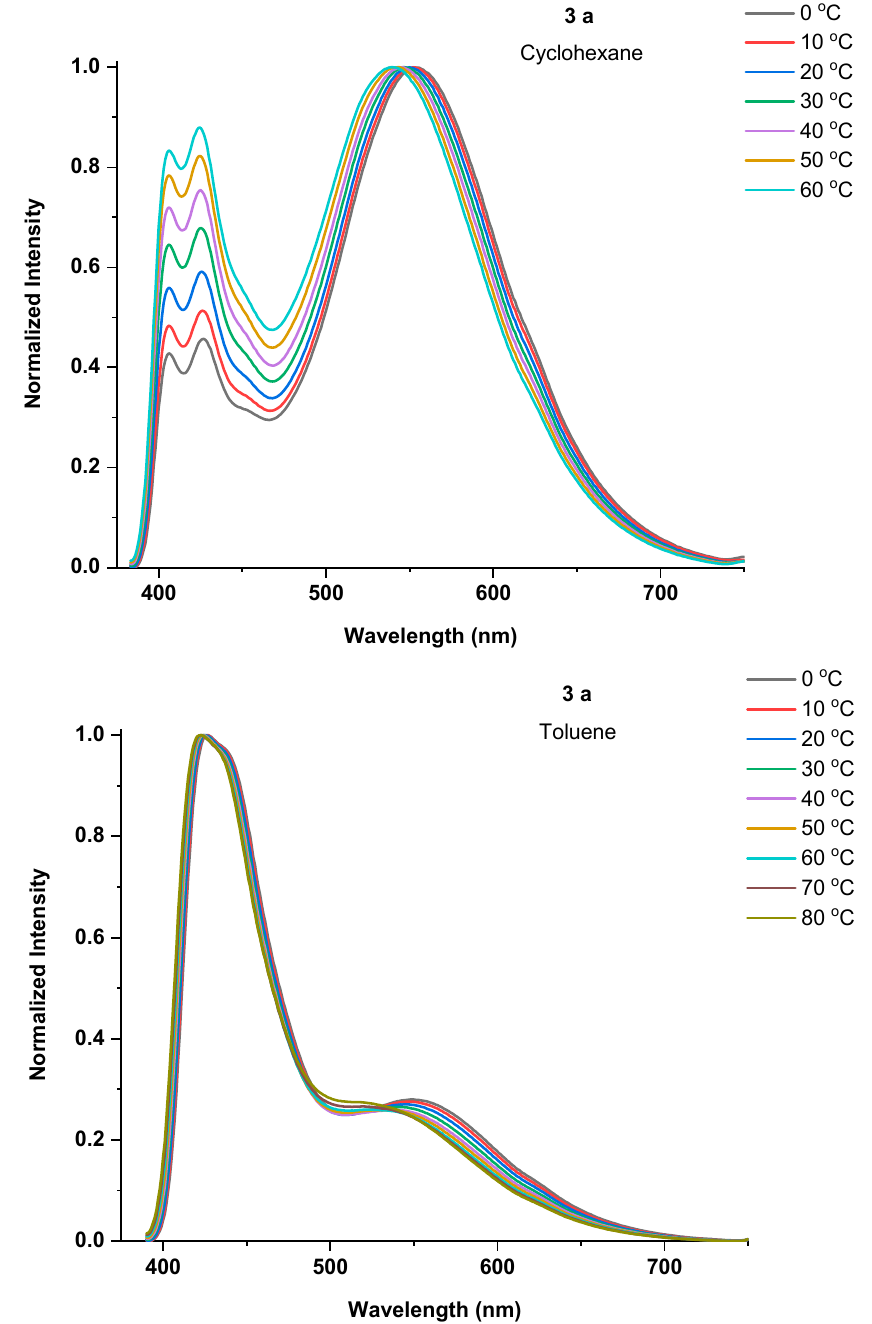
Figure 25. Normalized emission spectra of polymer 3 a in cyclohexane ( top ) and toluene ( bottom ) at different temperatures. Table 3. I ex /I m ratio in cyclohexane and toluene solutions of polymer 3 a at different temperatures.